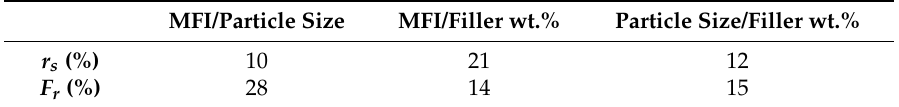
Table 2. Quantified metrics of two-dimensional analysis for the PP–talc system. MFI—melt flow